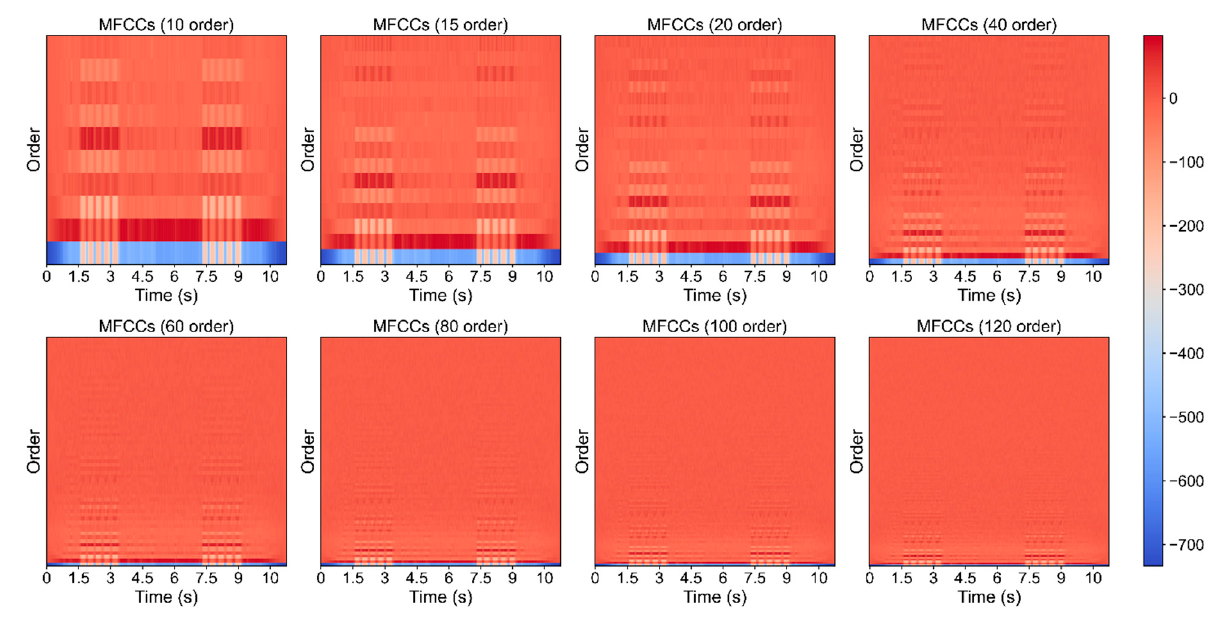
Figure 11. Comparison of multiple orders of MFCCs.